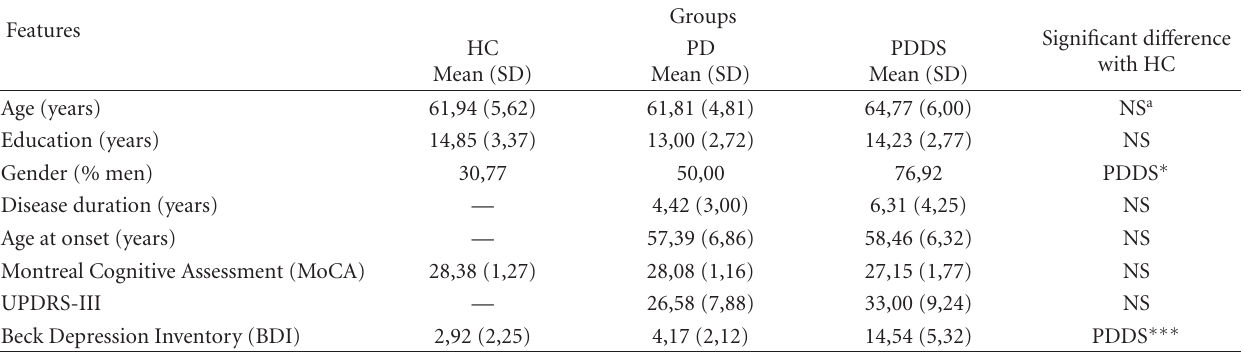
Table 1: Demographic and clinical characteristics of healthy controls (HCs) and participants with Parkinson’s disease with (PDDS) and without (PD) depressive symptoms.